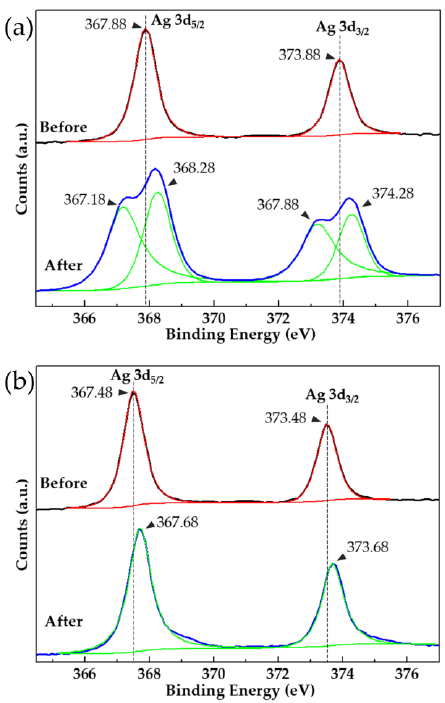
Figure 6. Ag3d XPS spectra before and after heat treatment at 250 °C for 30 min: ( a ) pure AgNWs and ( b ) AgNW – Al 2 O 3 composite film.